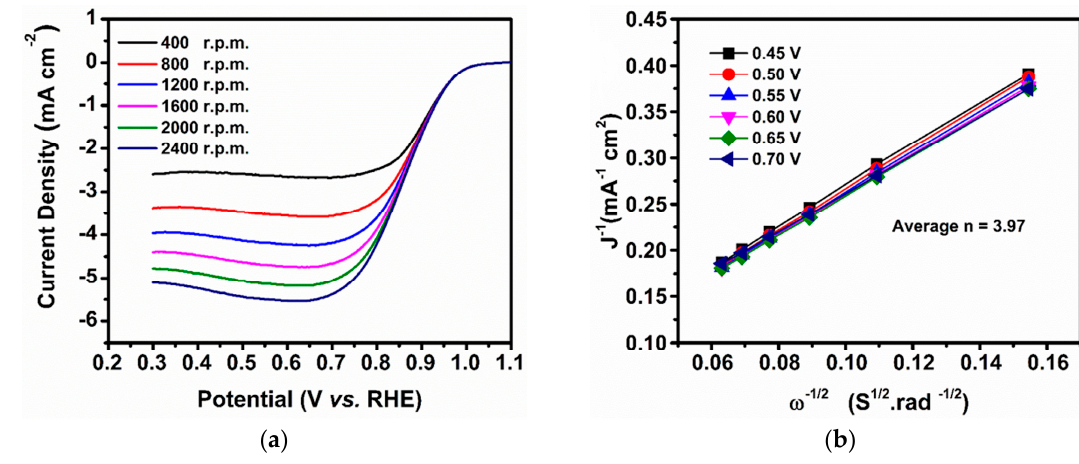
Figure 4. ( a ) CV curve of Cu@Cu 2 O core-shell nanocatalyst on glassy carbon disk electrode in O 2 -saturated 0.1 M KOH with a scan rate of 0.02 V s − 1 ; ( b ) LSV curves of Cu@Cu 2 O core-shell nanocatalyst on glassy carbon electrodes in O 2 -saturated (i) and Ar-saturated (ii) 0.1 M KOH with a scan rate of 0.02 V s − 1 .